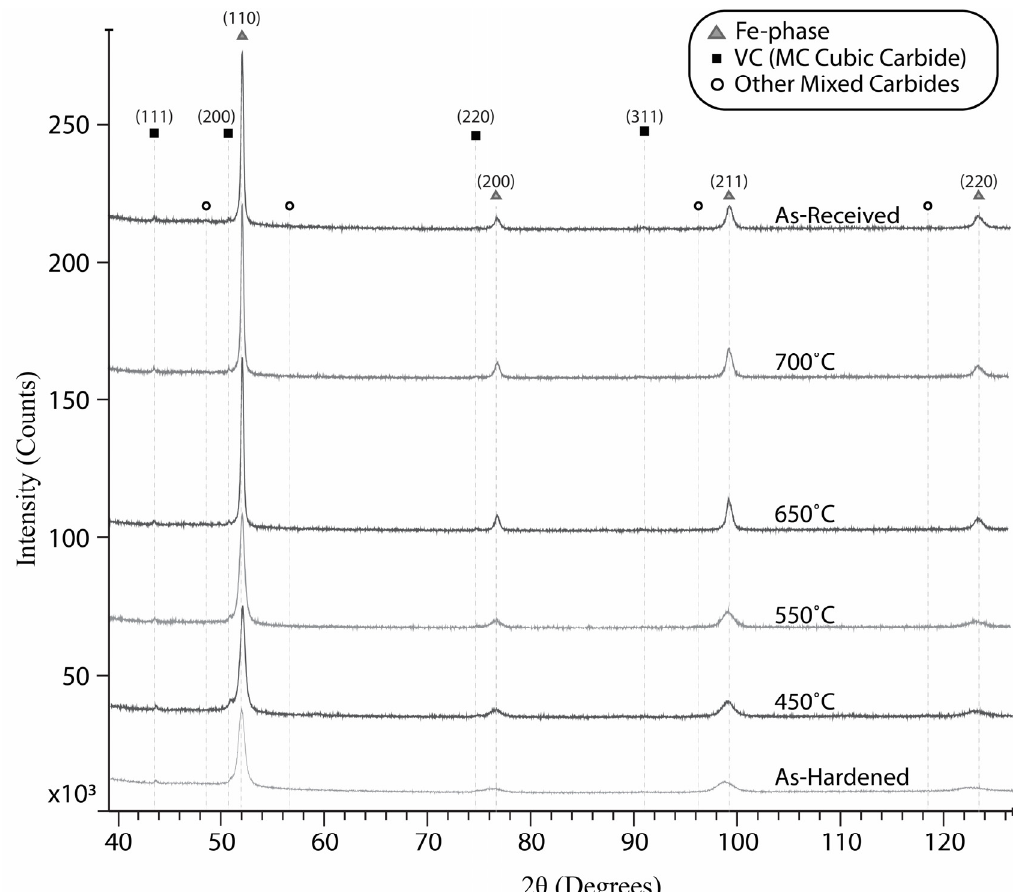
Figure 8. Offset plot of the XRD fractogram at each level of the treatment. Crystallographic peaks and Miller indices were identified by MDI software. Iron peaks narrow and increase in intensity most notably after 650 °C.